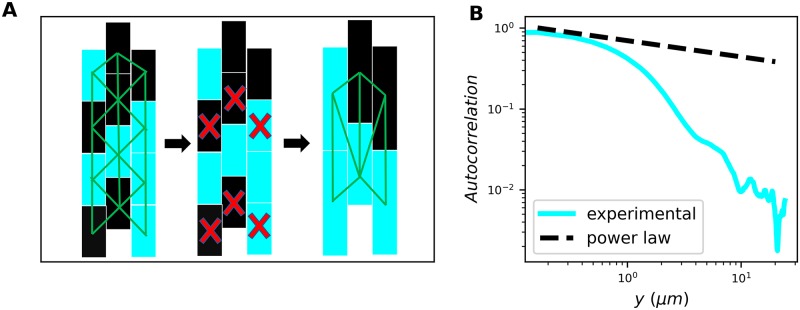
Short-range correlations do not affect critical properties.(A) Illustration of the renormalization argument: upon site decimation, lattice remains triangular, ϕ remains constant, and ρ vanishes. (B) Correlation function in experiments is short-range, i.e. sub-power-law (N = 3 biofilms).